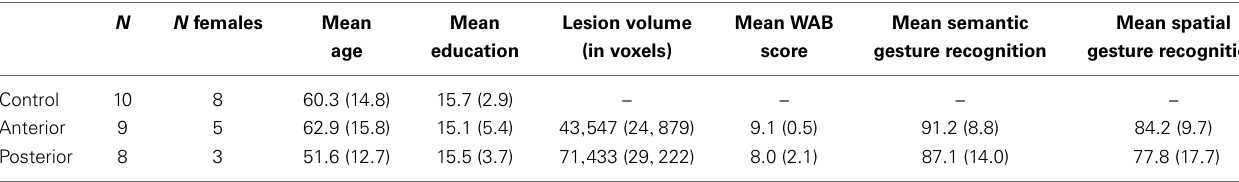
Table 1 | Demographic information about all participants.